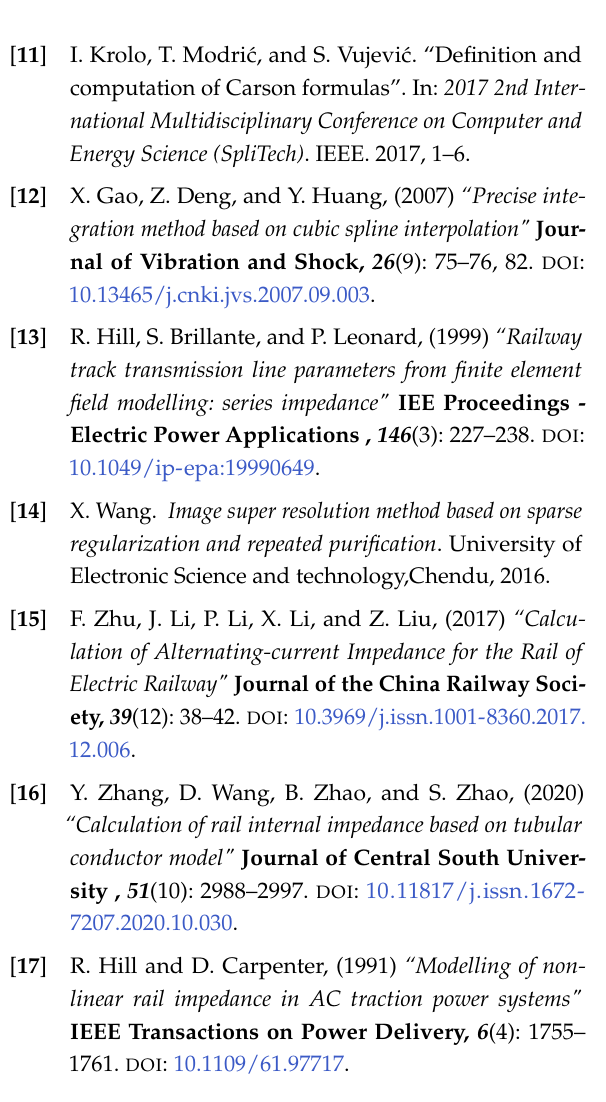
Fig. 13. Variation of rail mutual impedance with soil